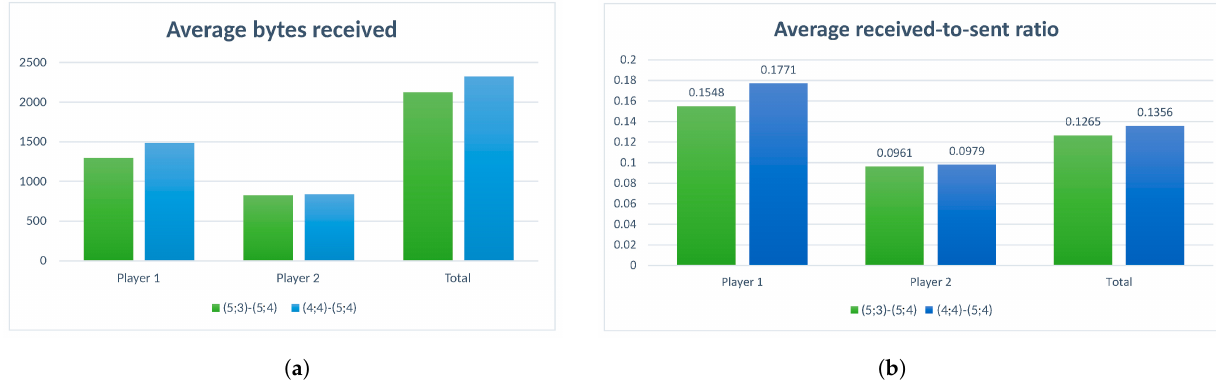
Figure 7. Two diagrams illustrate the improvement in Network 2 performance for the individual networks of Player 1, resp., Player 2, and the total network. Subfigure ( a ) shows the average bytes received for both Pareto optimal solutions (5;3)–(5;4) (dark green) and (4;4)–(5;4) (darker blue). The second histogram in Subfigure ( b ) illustrates differences in received to sent